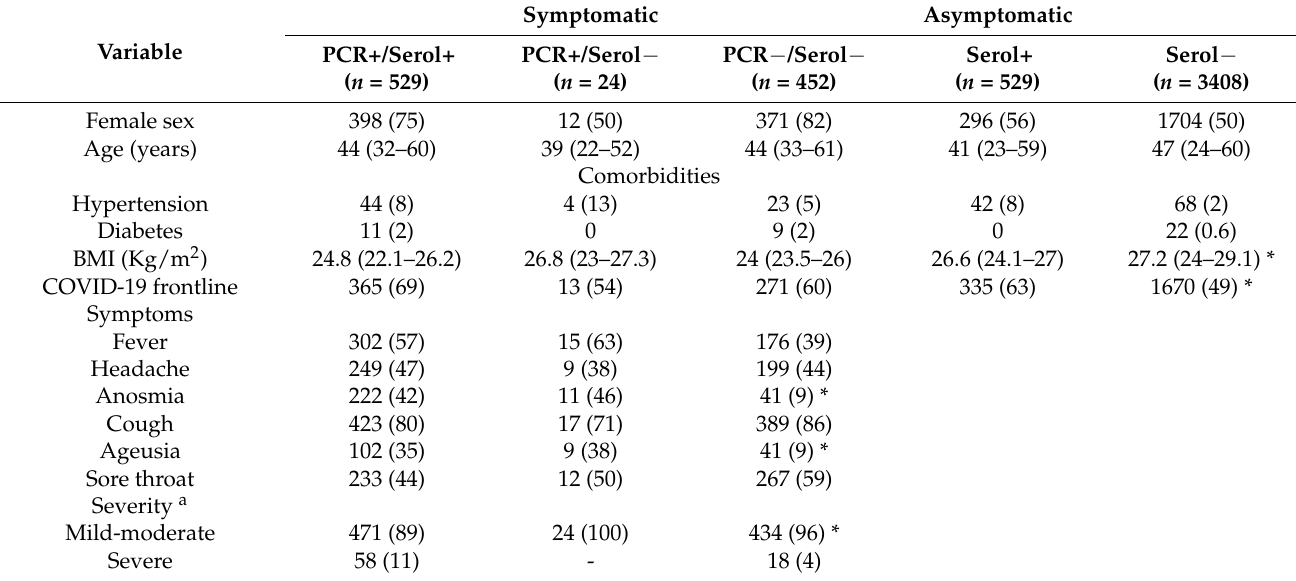
Table 1. Clinical features of HCWs according to COVID-19 presentation in the inception